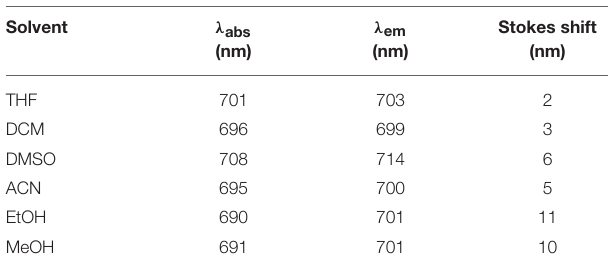
TABLE 1 | Selected photophysical properties of VG21-C12 in different